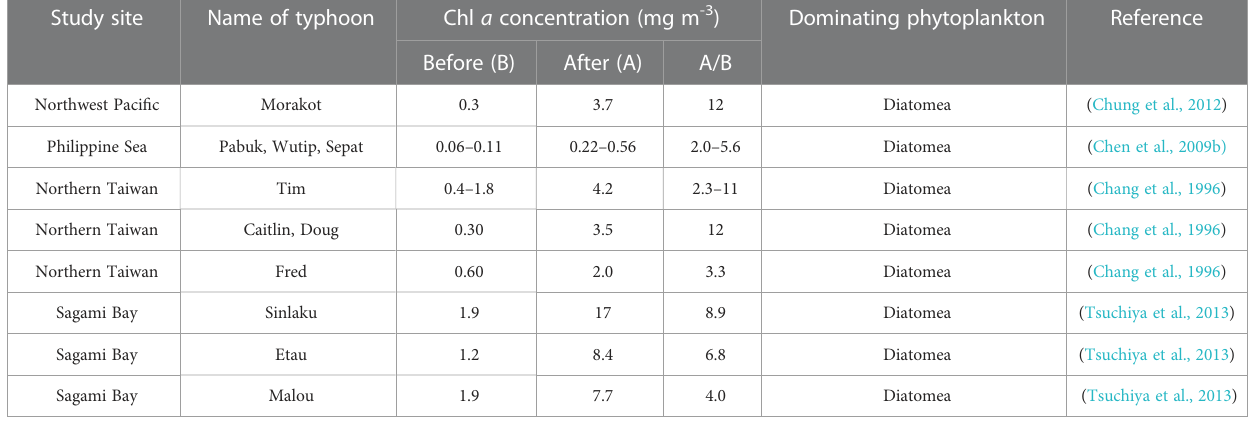
TABLE 1 Summary of Chl a concentrations and the dominanting phytoplankton after 11 typhoon passages. Study